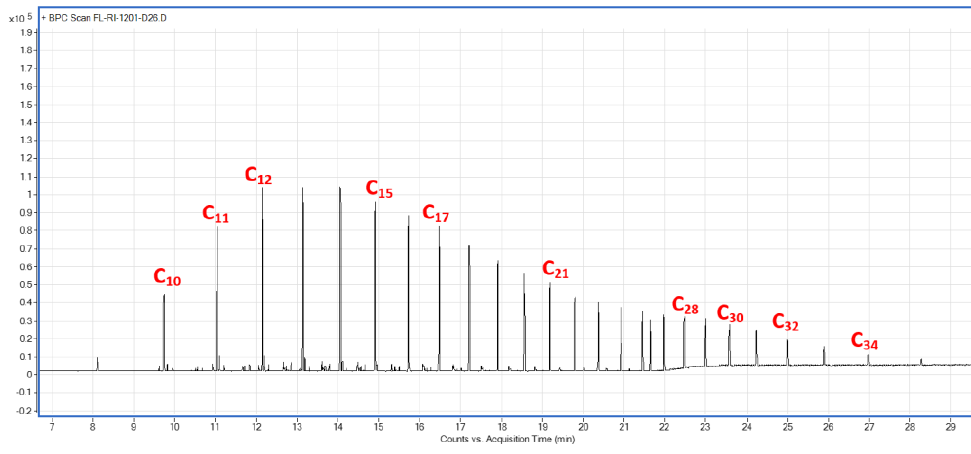
Figure A11. Trapped wax chromatogram analysis for R4.